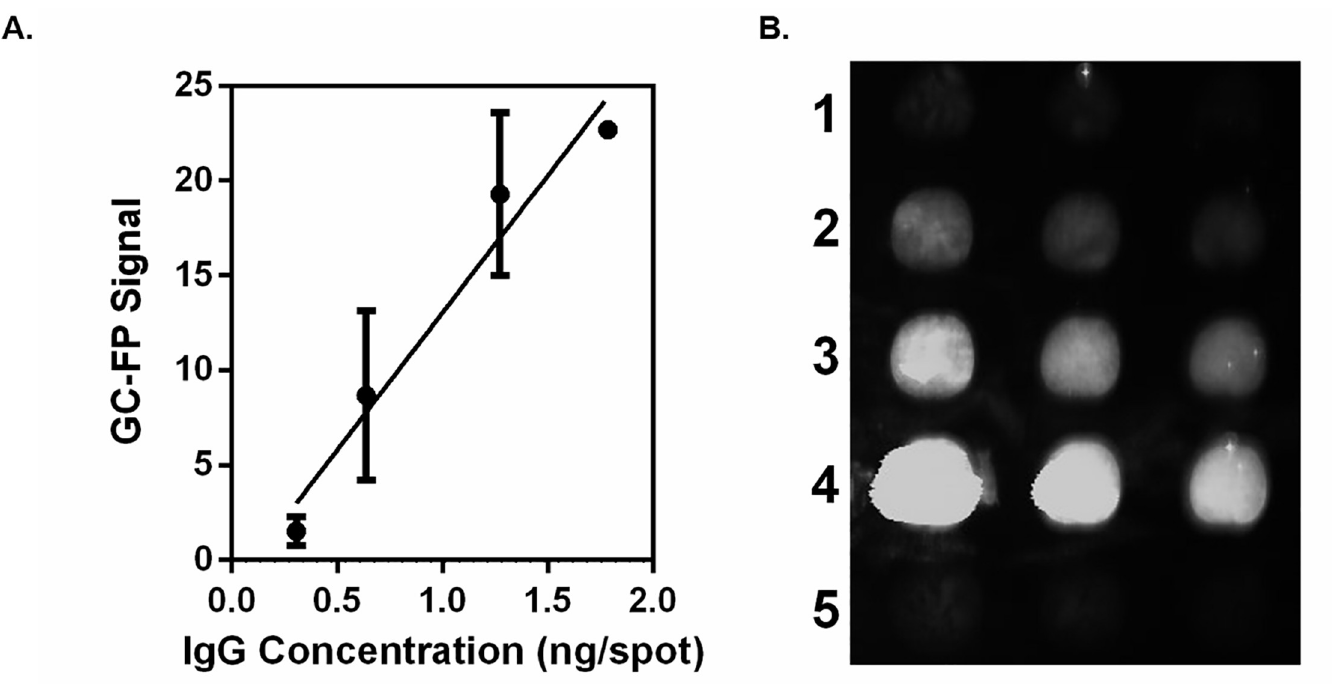
Fig 3. The GC-FP platform and its linear range of IgG antibody detection. (A) A GC-FP biochip coated with various amounts of IgG (0.306, 0.638, 1.275, and 1.785 ng/spot) was analyzed. The mean GC-FP signal ± Standard Deviation for each IgG concentration is plotted. Linear regression analysis of the plotted curve yields an R 2 value of 0.96. (B) The GC-FP image of spots from lowest to highest IgG concentration (1–4) is shown along with the negative control spots containing 1.275 ng/spot BSA (5). Qualitatively, IgG at 1.275 ng/spot and above is clearly visible above background signal.